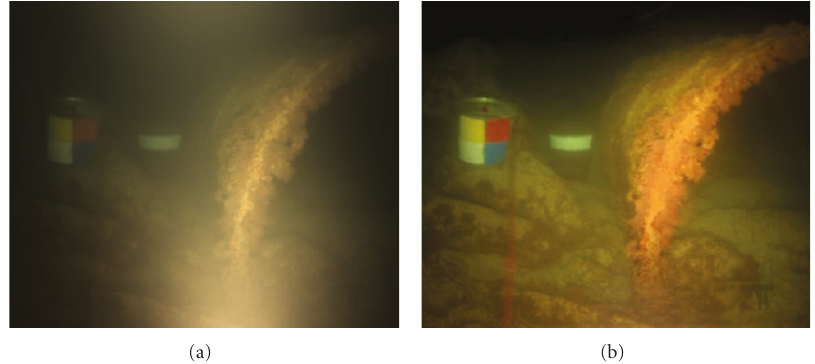
Figure 5: Raw image (a), De-scattered image (b) [19]. From http://webee.technion.ac.il/ ∼ yoav/research/active-descattering.html.